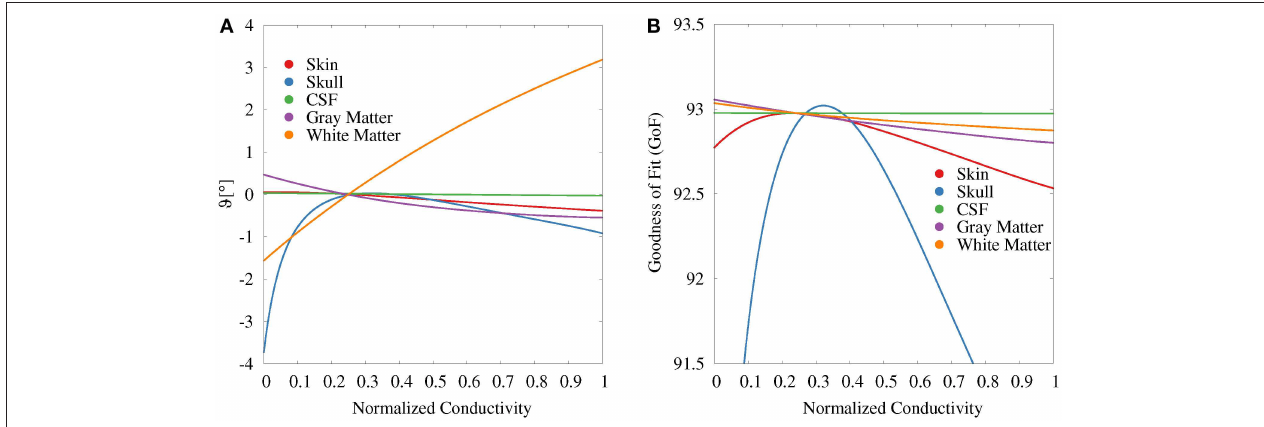
FIGURE 6 | Scatter plots of change in elevation angle ( ϑ , A ) and GoF (B) for GFS with fixed dipole location and free orientation as a function of the tissue conductivity for univariate distributions. Dipole location is chosen according to the initial dipole reconstruction (see section 2.3). Conductivities are normalized to the interval from 0 to 1 for clarity of the